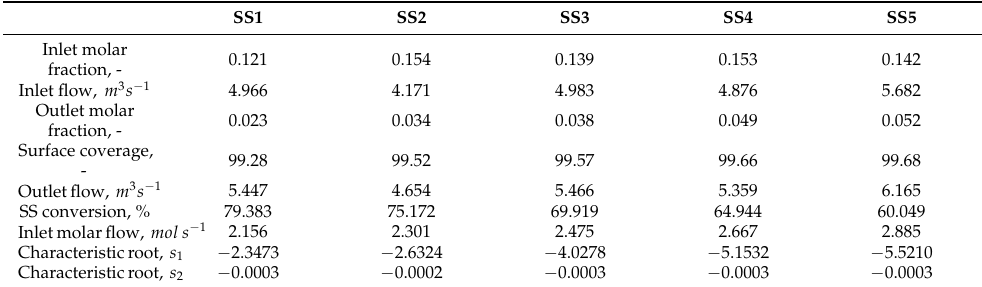
Figure 2. Pareto front for the steady-state operation of the photocatalytic reactor for formic acid decomposition, showing five points selected for analysis of periodic operations (SS1 to SS5, stars) and the corresponding points for periodic operation with modulation of the inlet molar fraction and volumetric flowrate optimised for maximal conversion (PO1 to PO5, circles). Table 3. Input, output parameters and the roots of the characteristic equation (Equation A1) for the five steady-state points of interest.